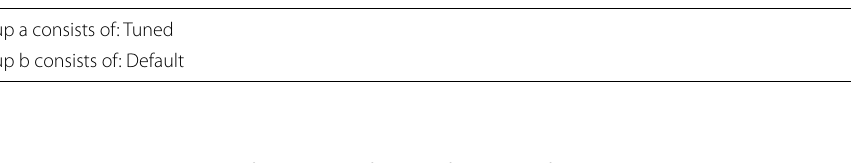
Table 31 HSD test groupings after ANOVA of AUPRC for the FST factor Group a consists of: 6 Agree, 5 Agree, All Features, 4 Agree Group b consists of: 7 Agree